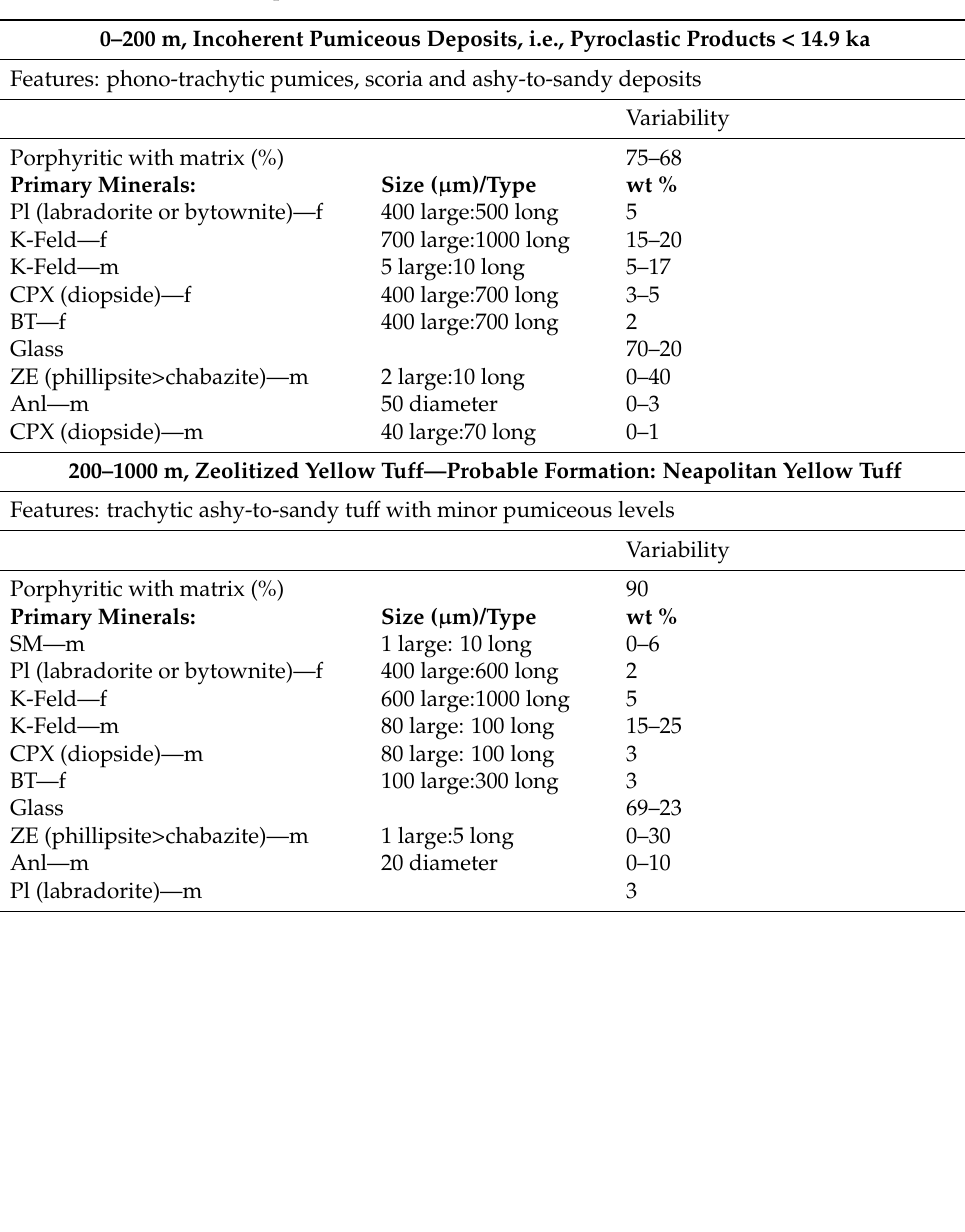
Table 1 lists the mineral parameters of protolith deposits through the buried stratigra- phy at the San Vito 1 well. We extrapolated the parameters by new and literature data on surface deposits and cores, on the basis of stratigraphic consideration and rearrangement of data, as explained below in Section 5.1.1; the needed input data for the geochemical model are shown for the selected Campanian Ignimbrite formation. Notably, since most outcropping tuffs are zeolitized, we showed evidence for the hypothesis that zeolites (not only analcyme) and smectite would be considered as primaries in the mineral setting. This possibility was not the object of this study and will be tested in future simulations. Table 1. Mineral features of